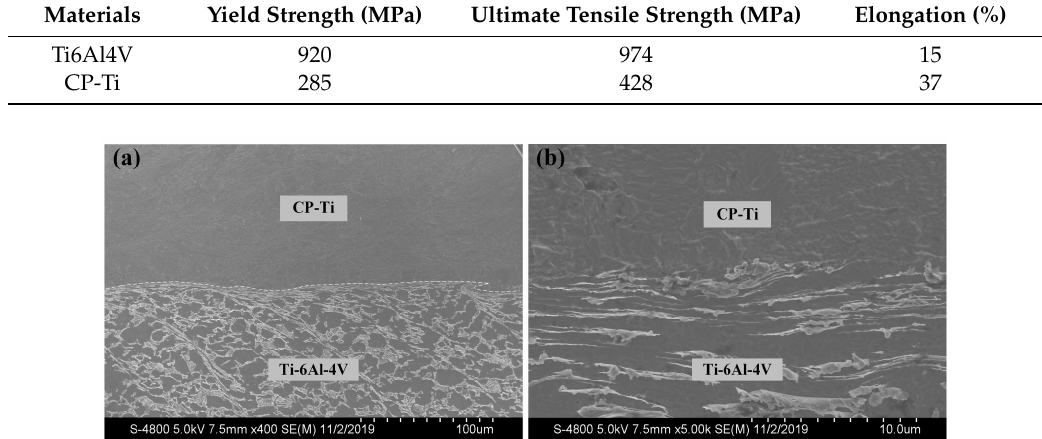
Figure 1. Microstructure of the Ti6Al4V / CP-Ti interface. ( a ) Scanning electron microscope image and ( b ) high magnification image.